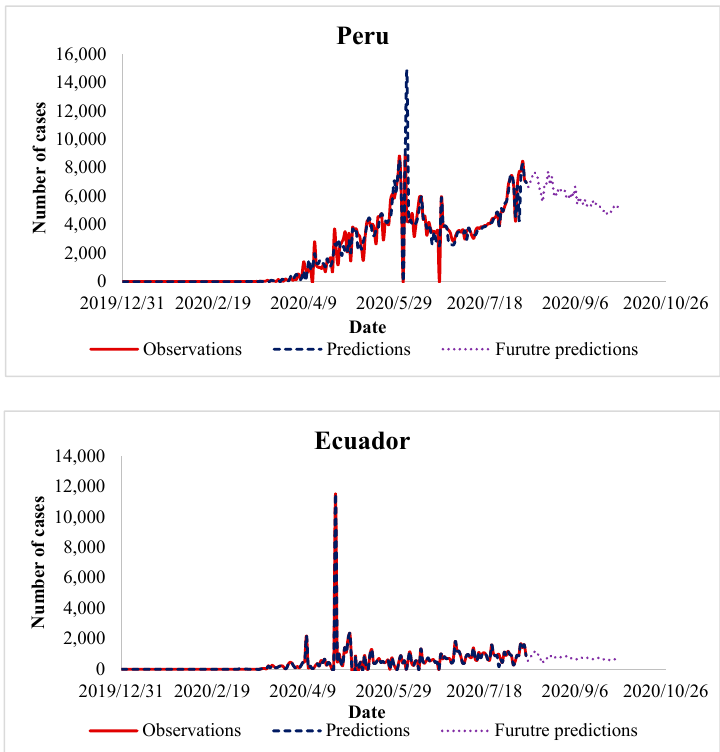
Figure 6. Future prediction of COVID-19 cases in North and South American countries.